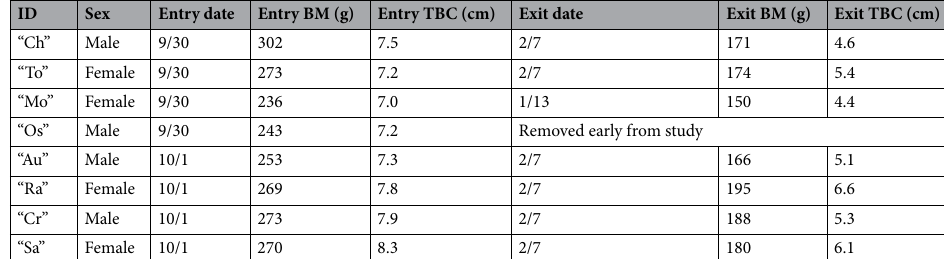
Table 5. The dwarf lemurs selected for the torpor study and their body masses (BM) and tail base circumferences (TBC) at the onset and end of the study.